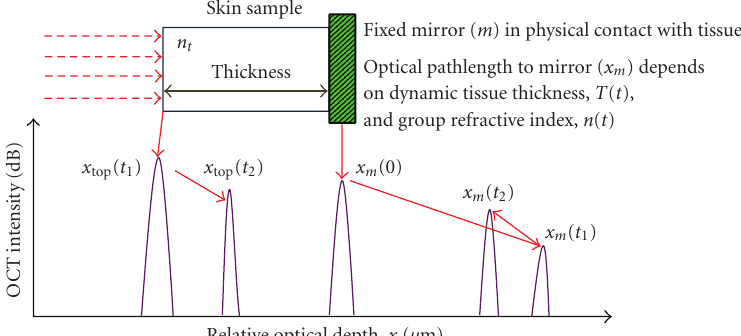
Figure 1: Schematic of Sorin and Gray’s optical pathlength shift method. x m ( t ) and x top ( t ) denote optical position of the fixed mirror and top surface of the sample, respectively.